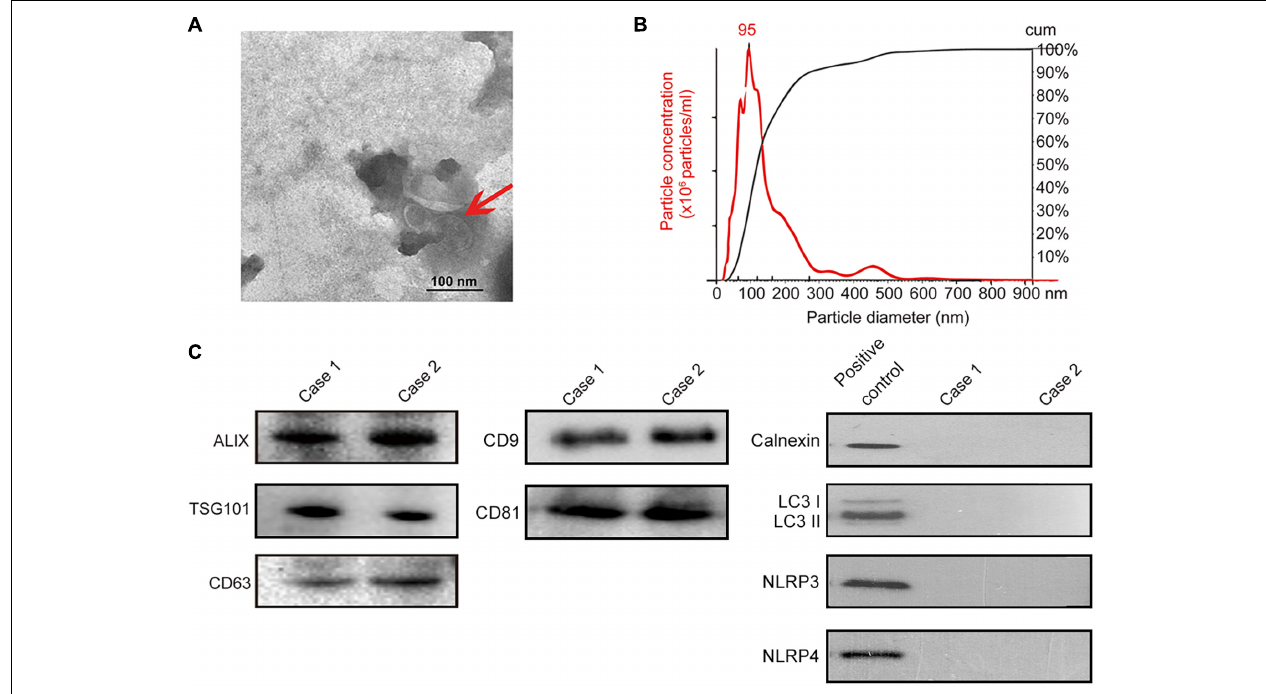
FIGURE 3 | Identification of salivary exosomes in periodontitis patients and normal subjects. (A) Transmission electron microscopy of exosomes isolated from human saliva. Scale bar: 100 nm. (B) Exosomes concentration and size distribution by NanoSight analysis of human saliva. (C) Immunoblotting showed the exosomal membrane markers (ALIX, TSG101 CD63, CD9 and CD81), the intracellular protein Calnexin, the marker of autophagosome LC3 and markers of inflammasome (NLRP3 and NLRP4) in exosomes isolated from the saliva of one normal subject (case 01) and one periodontitis patient (case 02). Positive control for Calnexin was TE1 cells, and positive control for LC3 was TE1 cells after starvation for 6 h. Positive control for NLRP3 and NLRP4 was THP-1 cells.